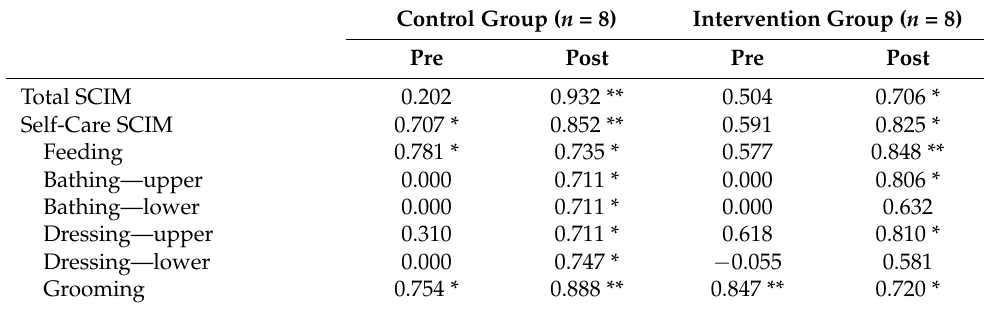
Table 4. Correlation between CUE (total scoring) and SCIM clinical scale when the dominant UL was the treated UL for both groups